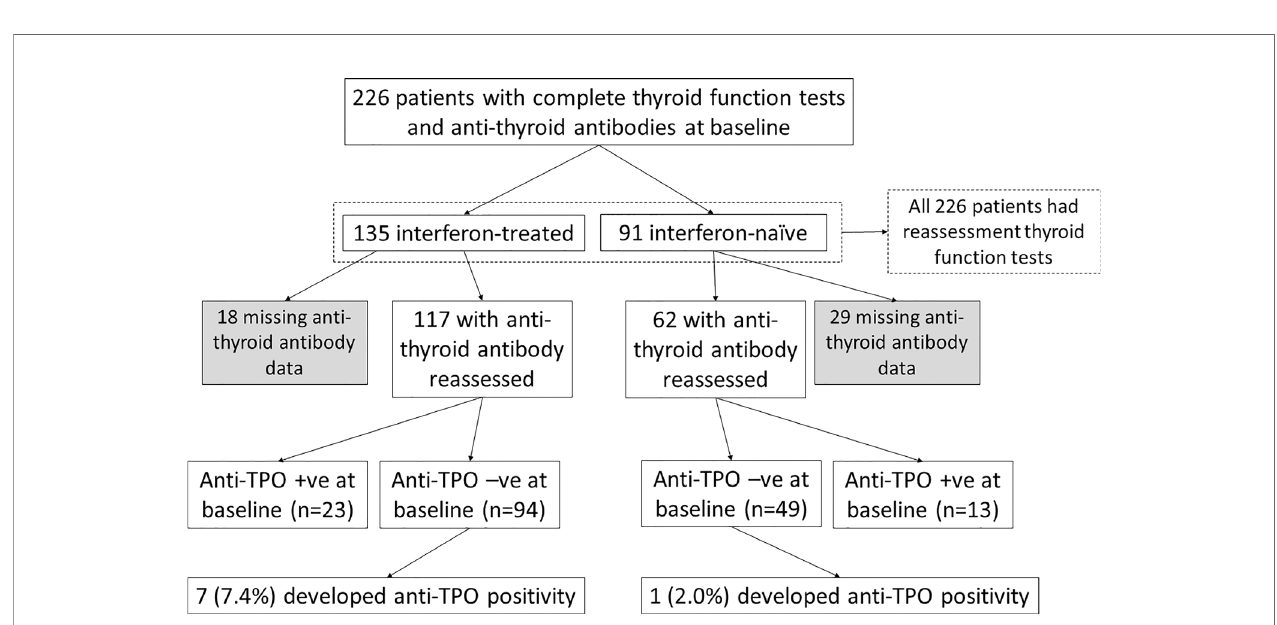
FIGURE 2 | Flow diagram of the